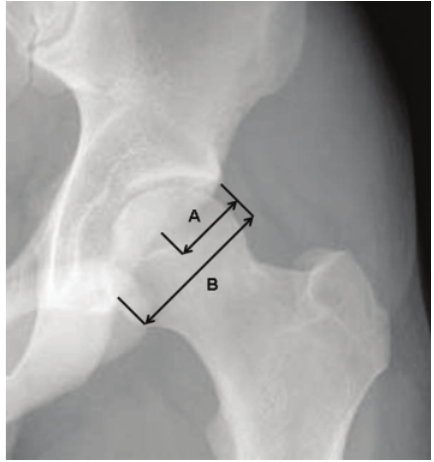
Figure 1: Illustration of the method used to calculate the overlap- ratio A: B. Distance A (extending from the lateral border of the acetabulum to the point where the anterior rim crosses the posterior rim) and distance B (extending from the lateral border of the acetabulum to its posteroinferior border).